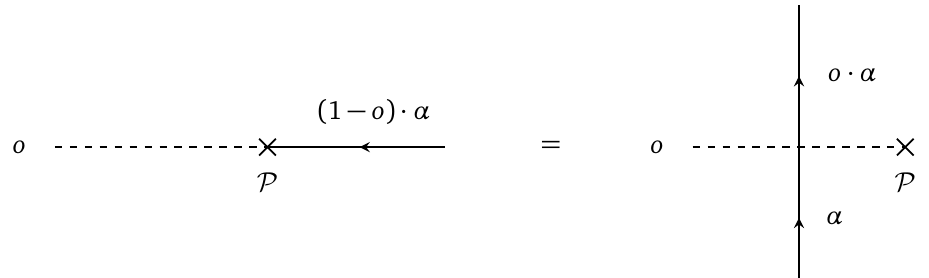
Figure 21: A surface defect ( 1 − o ) · α ending on an o -twisted puncture P can be topologically related to surface defect not ending on the